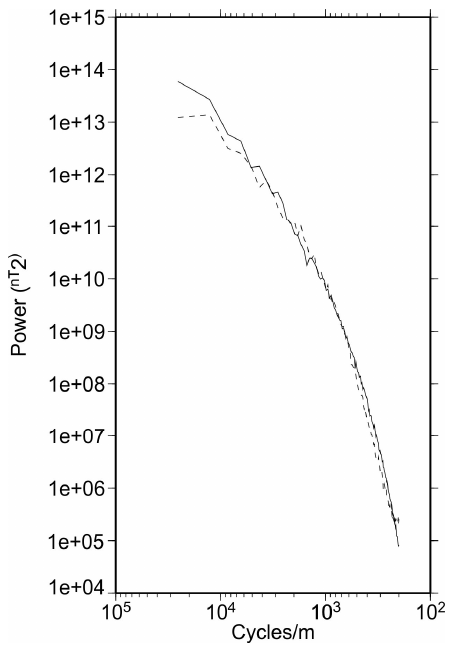
Fig. 2. Spectra of the fractal grid upward continued to 125 m (continuous line) and the measured magnetic data (dotted line).